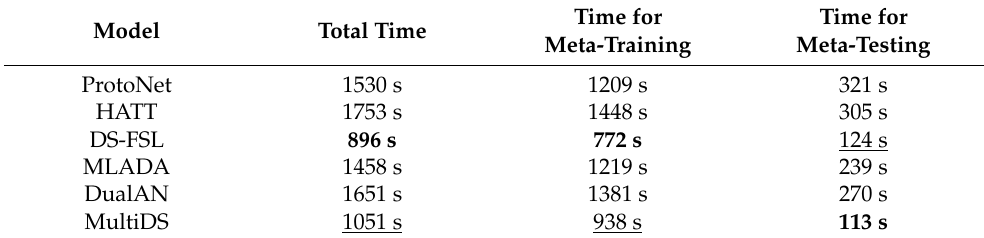
Table 9. Comparison of the computational time on Clinc → Banking under 10-way-1-shot. The best and second best results are emphasized using bold fonts and underlines,